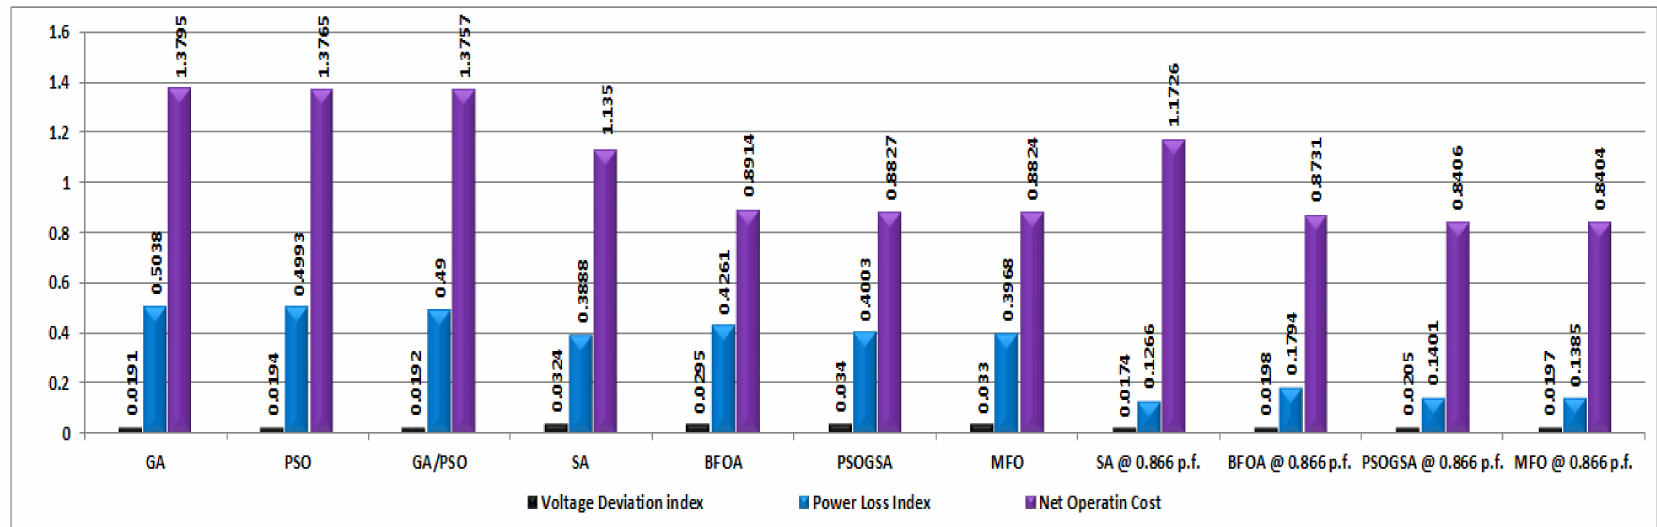
Figure 18. Comparison of different performances for 33-bus